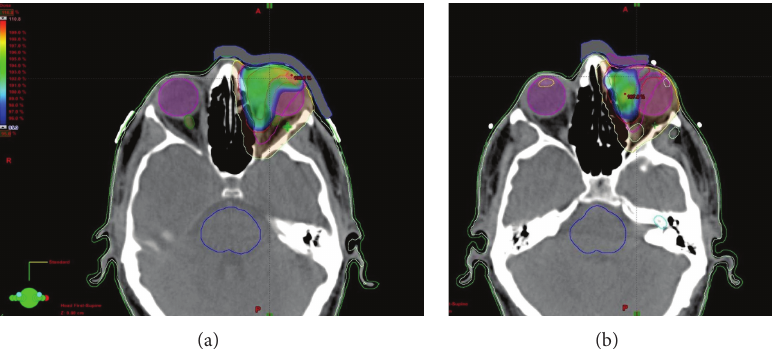
Figure 3: Intensity modulation radiation therapy (IMRT) to left medial canthus (a) 22.5 Gy in 15fractions to the clinical target volume (CTV), and (b) 30 Gy in 15fractions to the gross tumor volume (GTV) using 6 MV